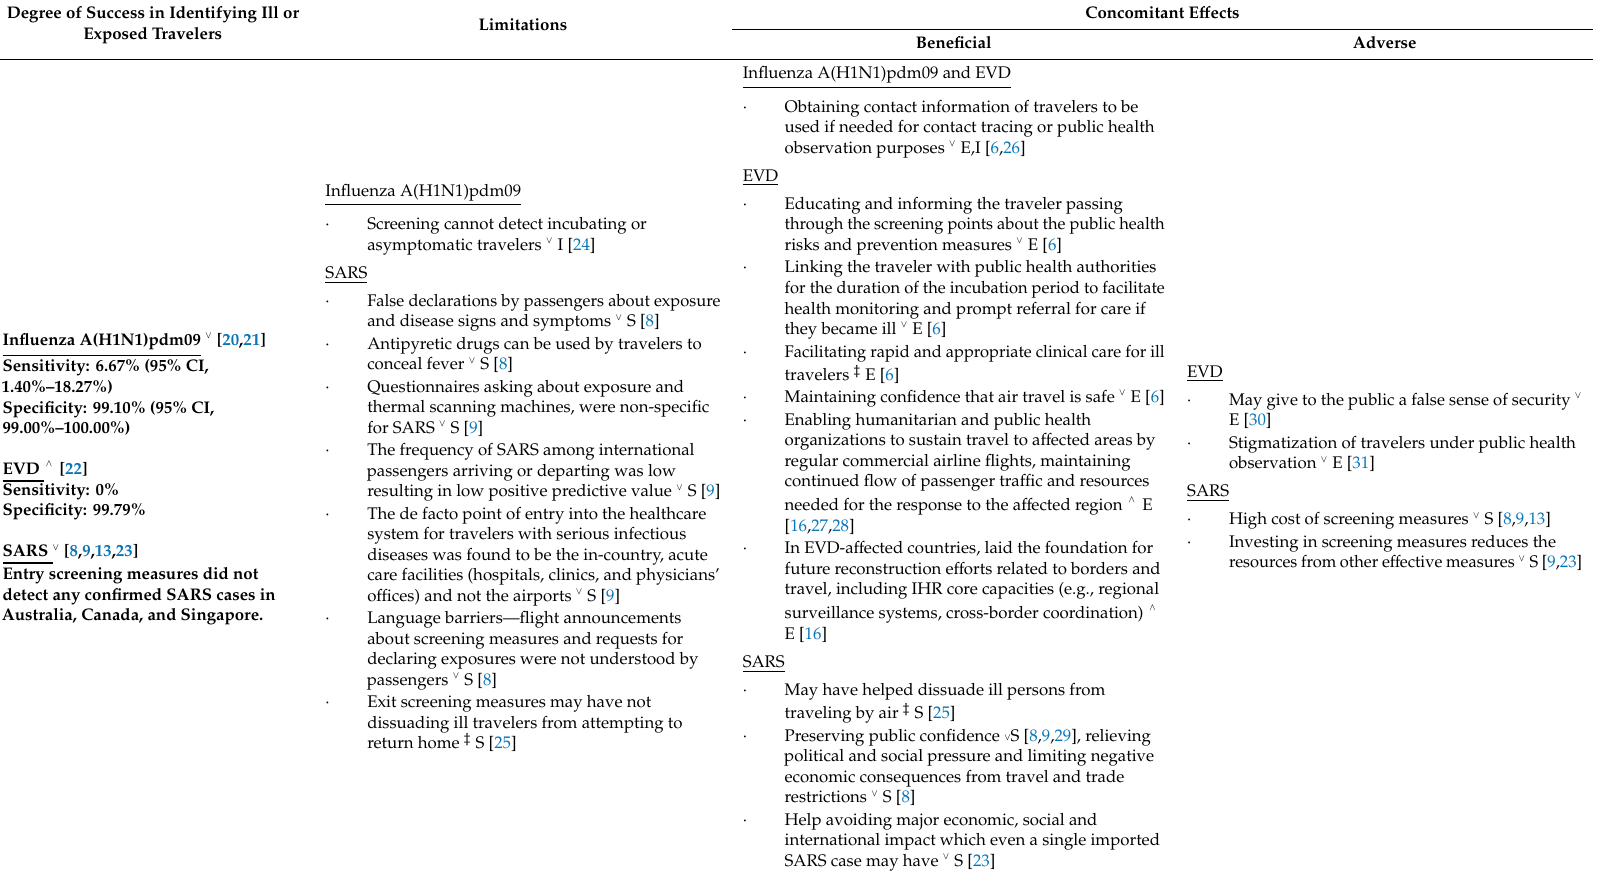
Table 3. Degree of success, limitations and concomitant effects of entry and exit screening at points of entry for Severe Acute Respiratory Syndrome (SARS), Influenza Pandemic (H1N1) 2009 (A(H1N1)pdm09) and Ebola Virus Disease (EVD).